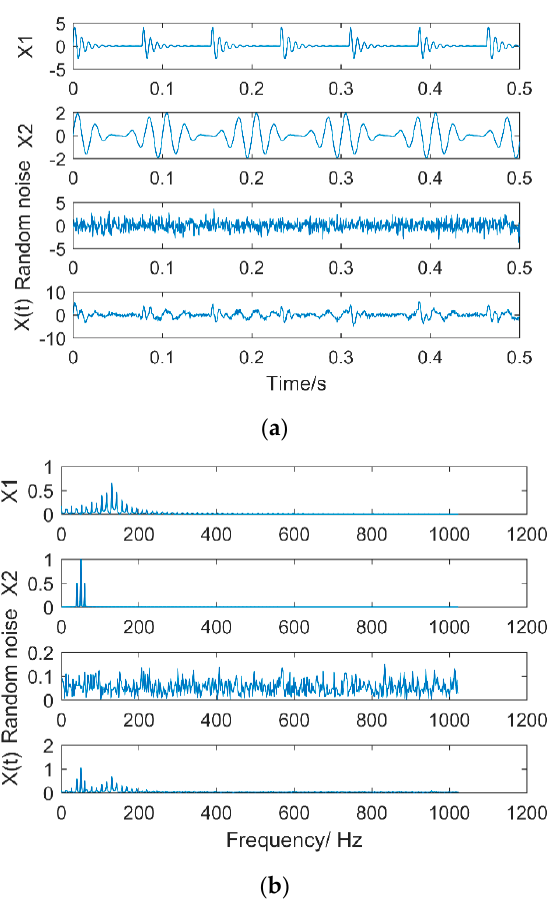
Figure 4. Simulation signal. ( a ) Time domain of simulation signal, ( b ) Frequency domain of simulation signal.